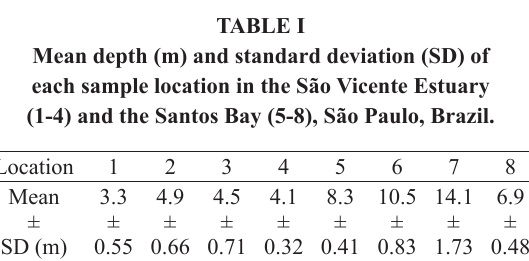
Fig. 1 - Map of study area indicating locations 1-4 in the São Vicente Estuary, and 5-8 in the Santos Bay, São Paulo, Brazil.